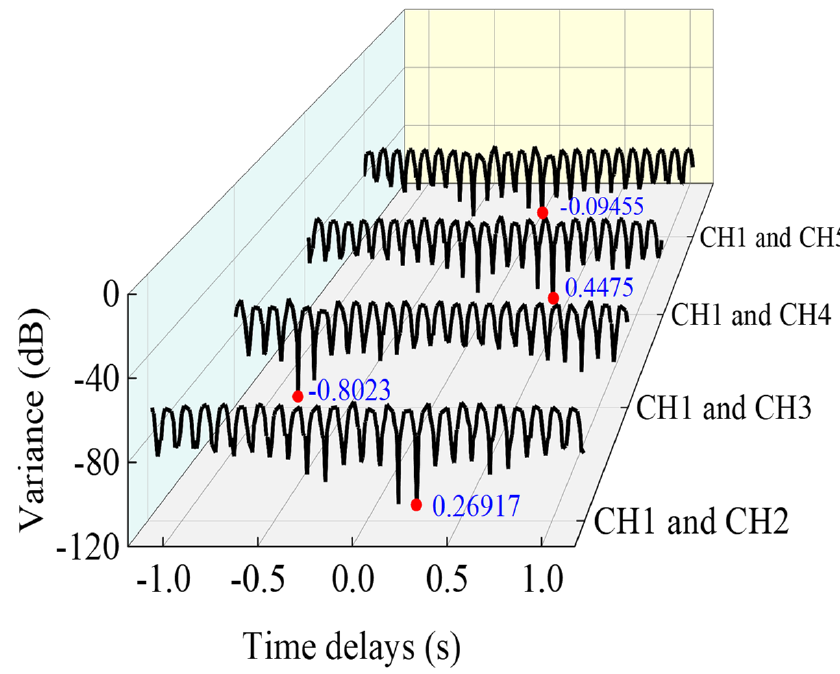
Figure 12. Relationships between delay and variance of candidate pool time lags.